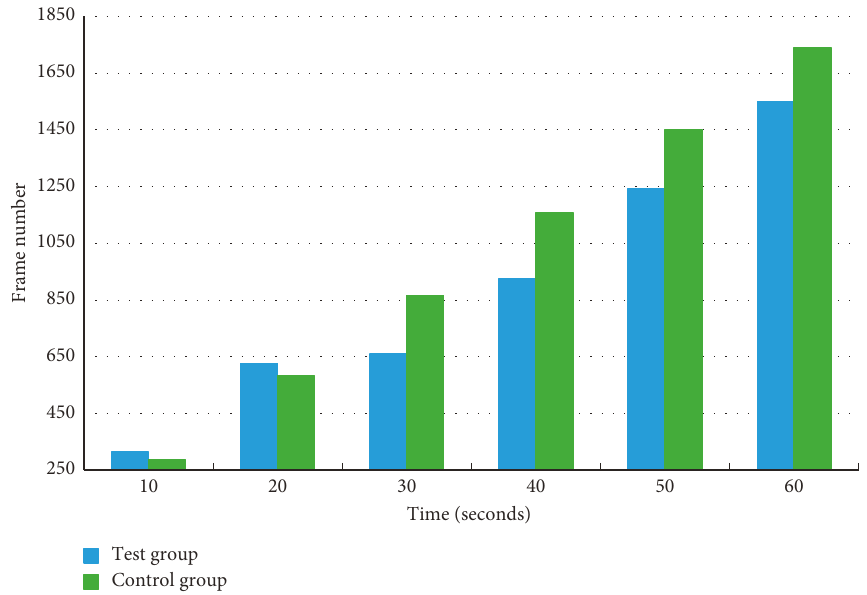
Figure 10: Frame rate data for experimental and control